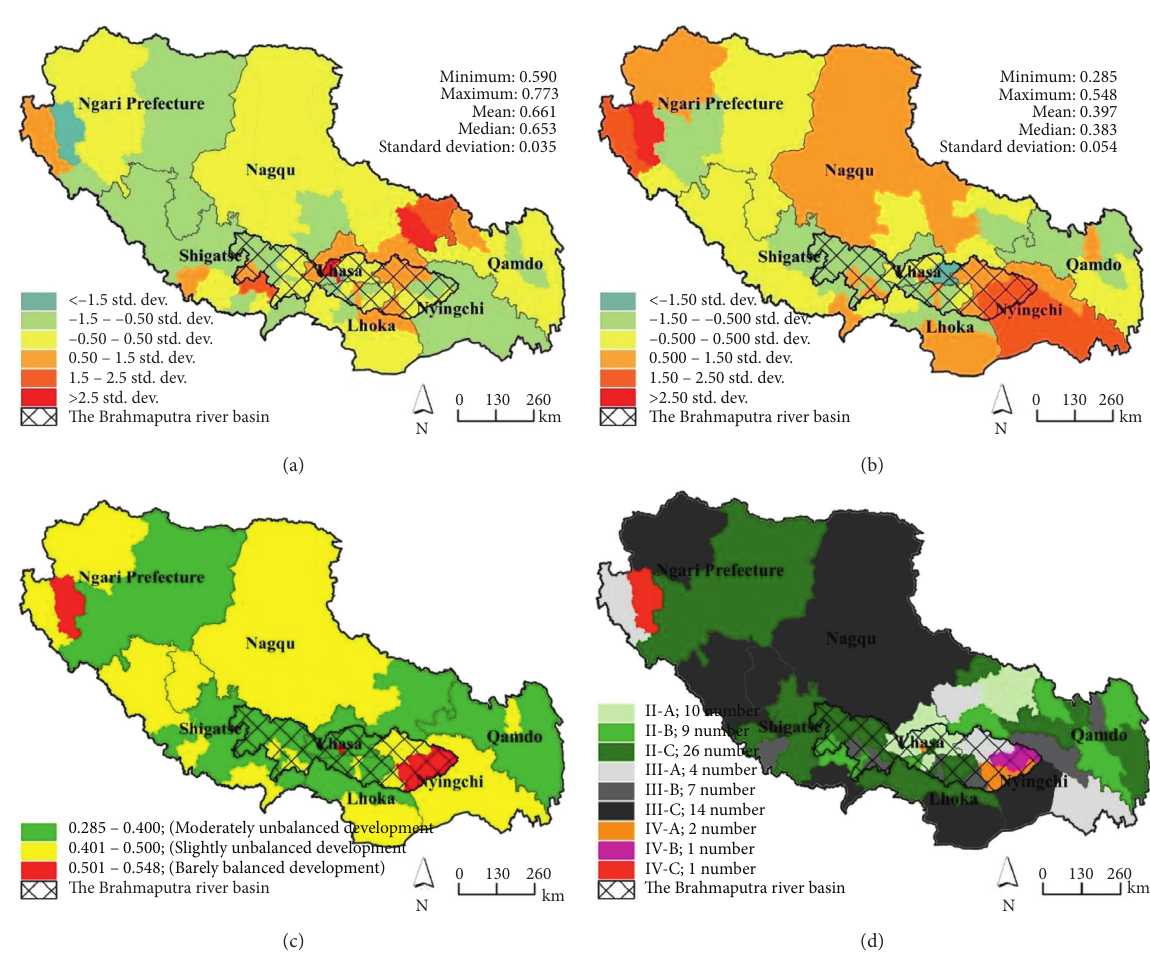
Figure 5: Spatial distribution of C and D , coupling coordination level, and coordinated development types of AT and TD in 2015. (a) Coupling degree ( C ). (b) Coupling coordination degree ( D ). (c) Coupling coordination level. (d) Coupling development